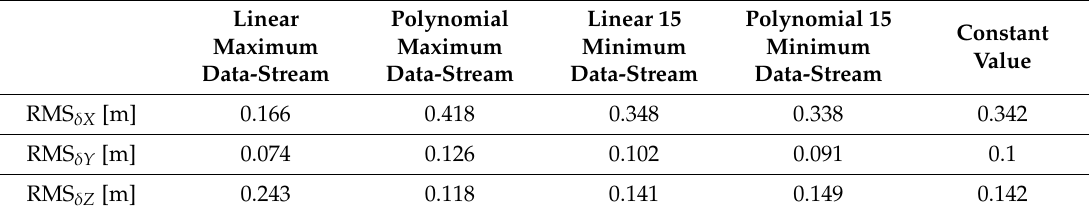
Table 3. The RMS values of the time series of geocentric corrections, referring to an out-of-date navigation message (GPS G30).